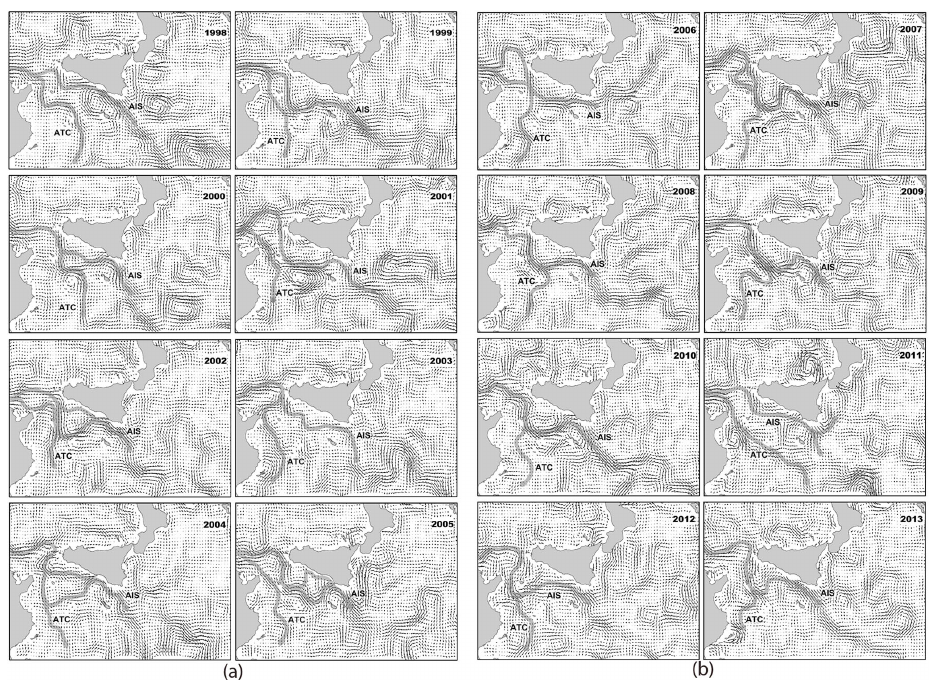
Figure 5. Mean geostrophic velocity field (absolute dynamic topography by Aviso) estimated in the period of each survey. The patterns of the main circulation streams (ATC and AIS) are evaluated by the AVISO altimeter products.